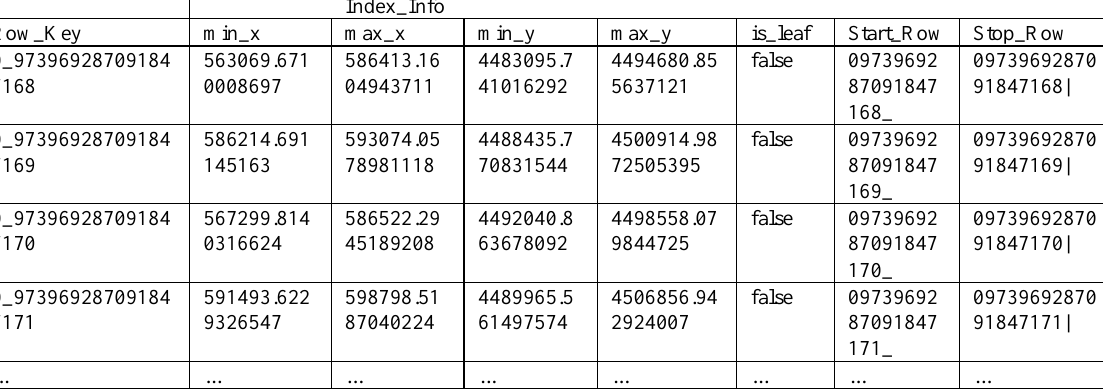
Table 3 . Design of index table in HBase.